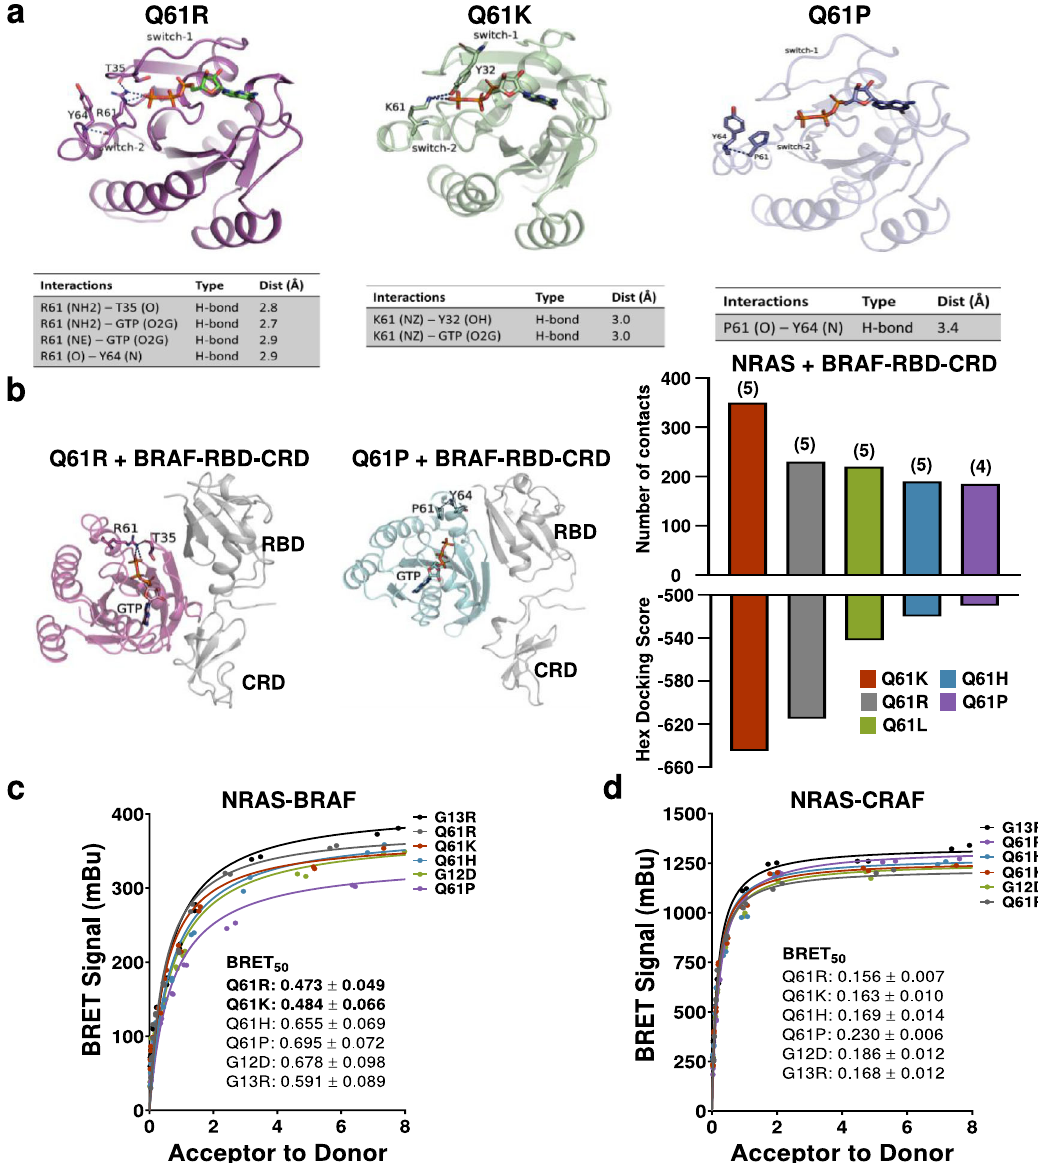
Fig. 7 Conformational changes induced by NRAS mutants alter BRAF binding af fi nity. a Representative conformations of NRAS 61R , NRAS 61K , and NRAS 61P extracted from their highly populated replica-exchange molecular dynamics (REMD) structural ensembles. Interactions with the codon 61 sidechain are listed below each structure. b Binding orientation of NRAS 61R and NRAS 61P with the BRAF-RBDCRD as generated using Hex molecular docking simulations. The average conformation representing highly populated structural ensembles extracted from each NRAS codon 61 mutant trajectory was docked against the BRAF-RBDCRD. In the cartoon representation, the NRAS codon 61 mutant and bound nucleotide are shown in licorice, the BRAF- RBDCRD in gray and polar interactions for each mutant, and its surrounding residues are indicated by blue dashed lines. Comparisons of the interaction energy and the number of contacts between the BRAF-RBDCRD and each NRAS mutant suggest that highly melanomagenic NRAS mutants (NRAS 61R , NRAS 61K ) bind BRAF with higher af fi nity than NRAS 61H , NRAS 61L , and NRAS 61P . The number of autoinhibitory contacts relieved by NRAS mutant binding is listed in parentheses. BRET protein – protein interaction data from Venus-tagged NRAS mutant and Rluc8-tagged BRAF ( c ) or CRAF ( d ) constructs co- transfected into 293T cells at increasing receptor to donor ratios. The data shown are representative of two replicates. Best fi t BRET 50 values (binding af fi nity) and standard error, determined by non-linear regression, are shown for each mutant. Bolded values indicate statistically signi fi cant values as compared to both NRAS 61H and NRAS 61P . p -values determined by t-tests with 20 degrees of freedom representing the number of measures per curve. Source data are provided as a Source Data fi